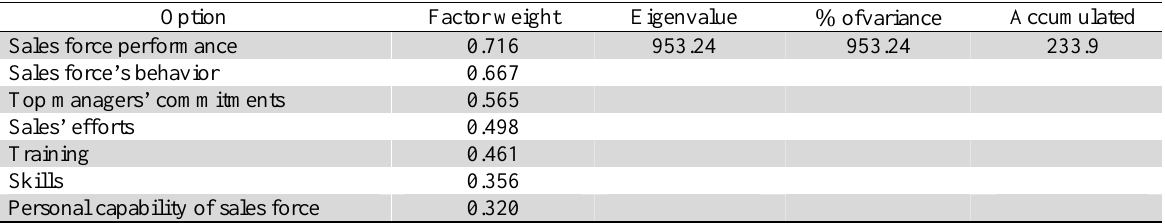
Fig. 1. Distribution of participants’ age Fig. 2. Distribution of participants’ educations